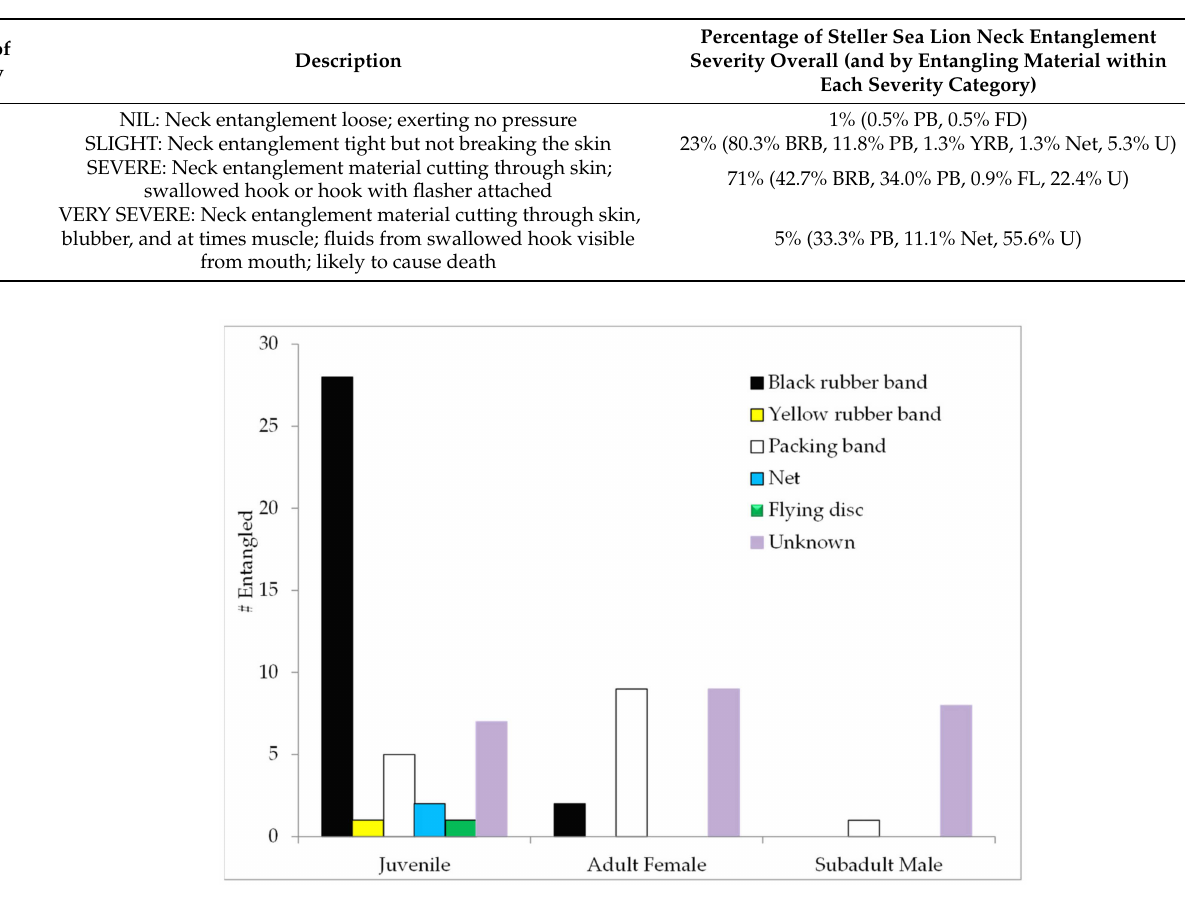
Figure 7. Number of juvenile, adult female, and subadult male Steller sea lions entangled by entanglement material observed during surveys in Oregon during